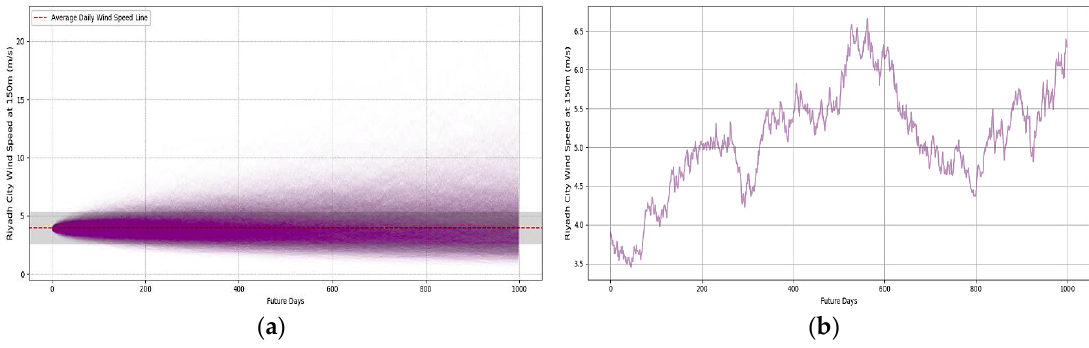
Figure 15. ( a ) Daily total solar DHI distributions for the south region, as predicted by MCS and BM, and ( b ) a one-day scenario for the solar DHI distribution prediction performance.